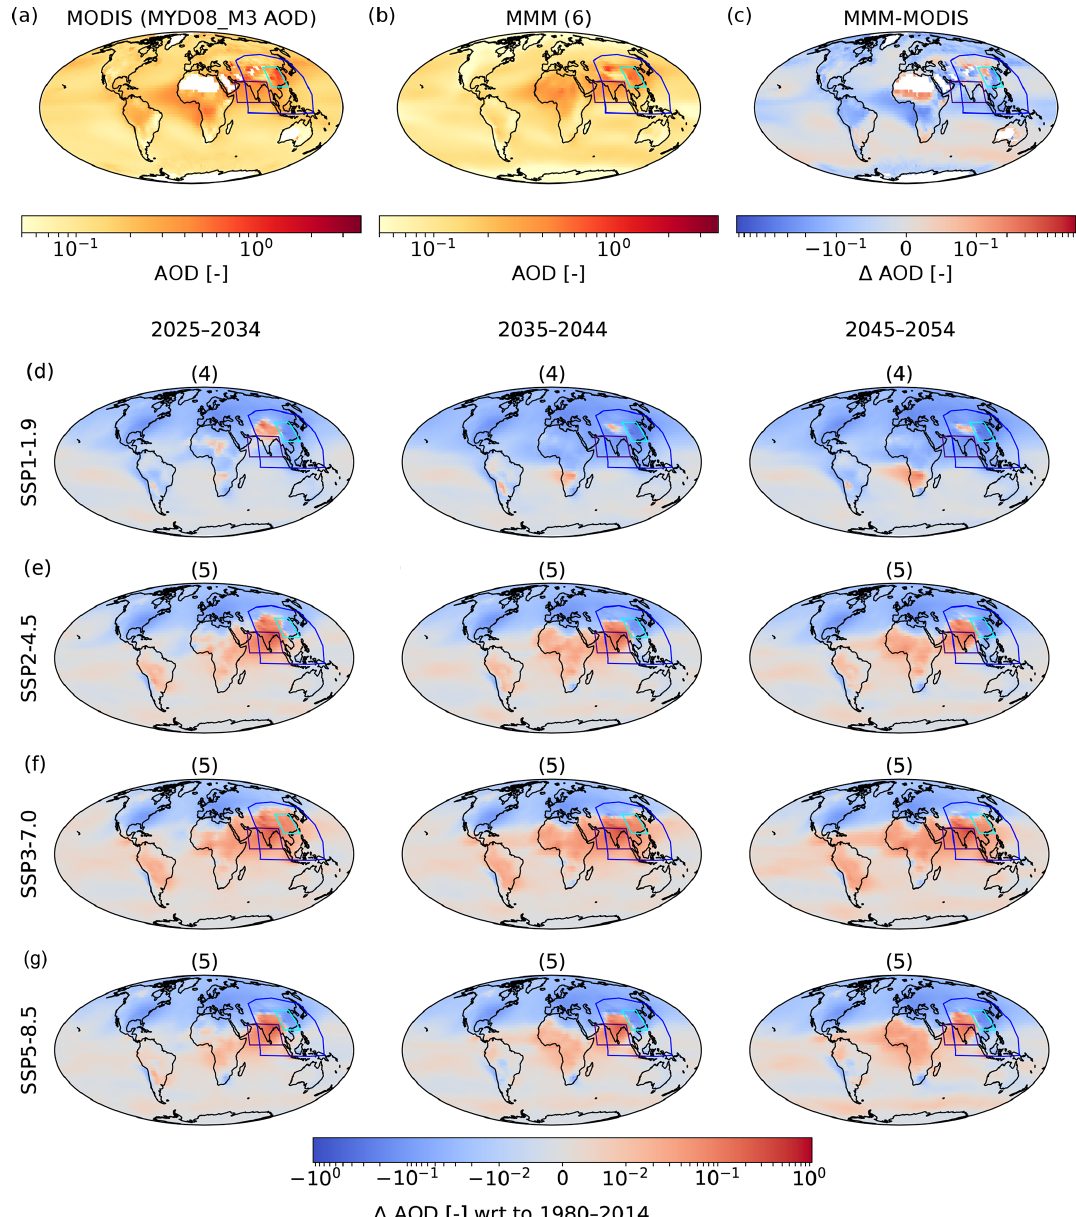
Figure 6. (a) 2002–2014 mean aerosol optical depth at 550nm from MODIS. (b) 2002–2014 mean CMIP6 multi-model mean aerosol optical depth at 550nm (based on six models; see Table 1). (c) CMIP6 bias relative to MODIS. CMIP6 AOD anomalies for 2025–2034, 2035–2044, and 2045–2054 vs. 1980–2014 for (d) SSP1-1.9, (e) SSP2-4.5, (f) SSP3-7.0, and (g) SSP5-8.5. For SSP1-1.9 the anomalies are based on four models. For all other panels, five models are used (Table 1). Blue, purple, and turquoise boxes show the “Asia”, “South Asia”, and “East Asia” regions used in later analysis. Asia is the region bounded by 5–47.5 ◦ N, 67.5–145 ◦ E, East Asia is the region bounded by 20–40 ◦ N and 100–120 ◦ E, and South Asia is the region bounded by 5–25 ◦ N and 55–95 ◦